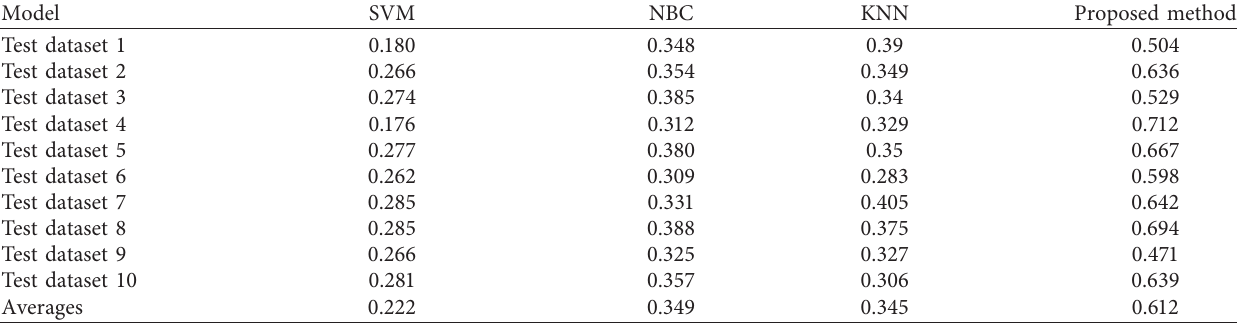
Table 6: Results of driving styles identification average macro-F1 in test datasets.